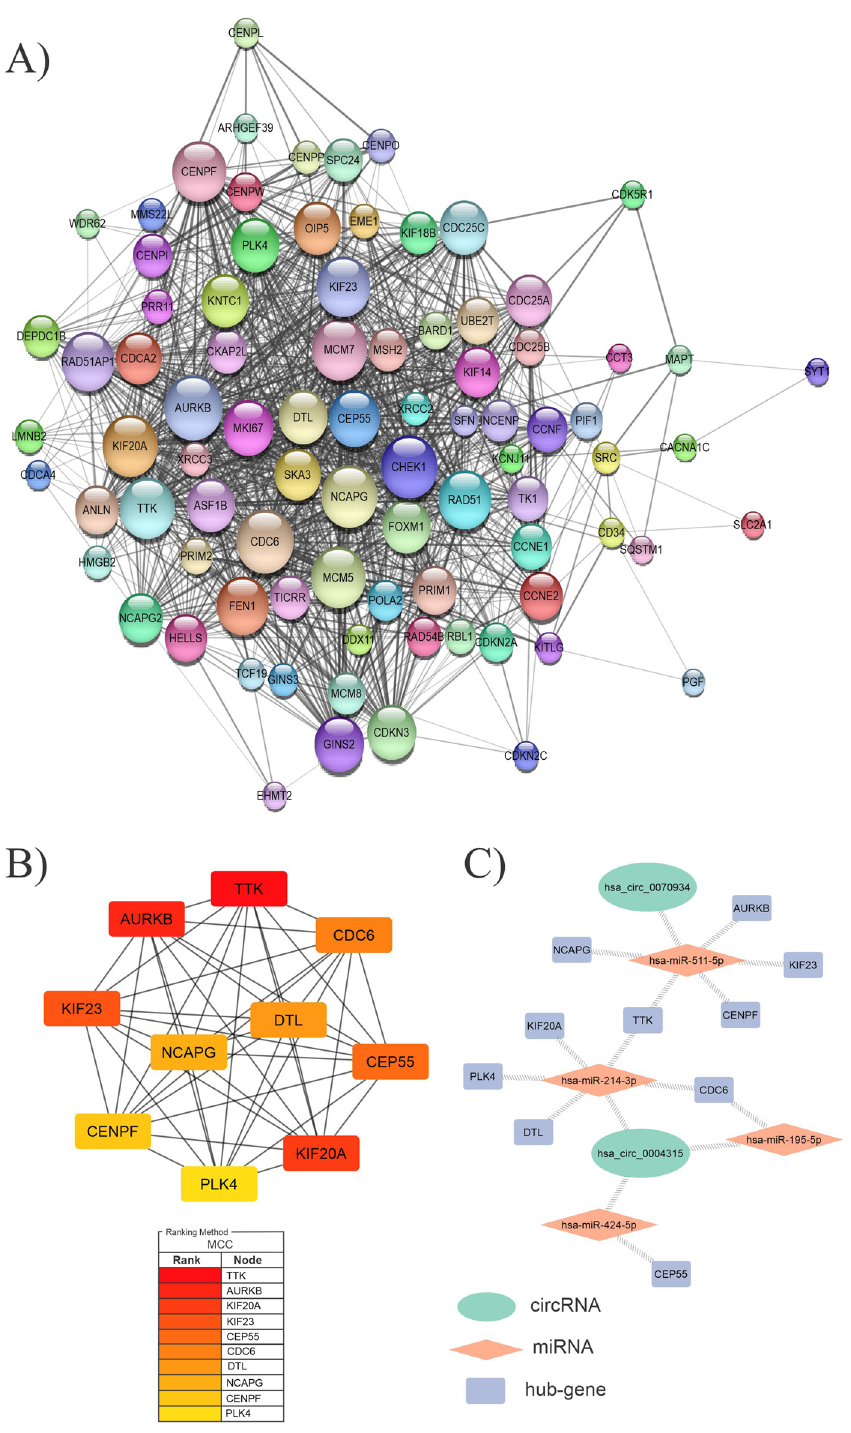
Figure 9. (A) A PPI network involving 204 genes has been associated with overall survival. The size of the node reflects the degree of value of the genes. ( B) a network of ten hub genes. MCC scores were used to determine the top ten hub genes in the PPI network using the CytoHubba plugin of the Cytoscape software. The figure shows the significance of hubs on a color scale ranging from red to yellow, with red being the most important and yellow being the least important. ( C) Network shows the interactions between selected DECs, FImiRNAs, and hub genes. DECs, FImiRNAs, hub genes are shown in green, red, and blue,